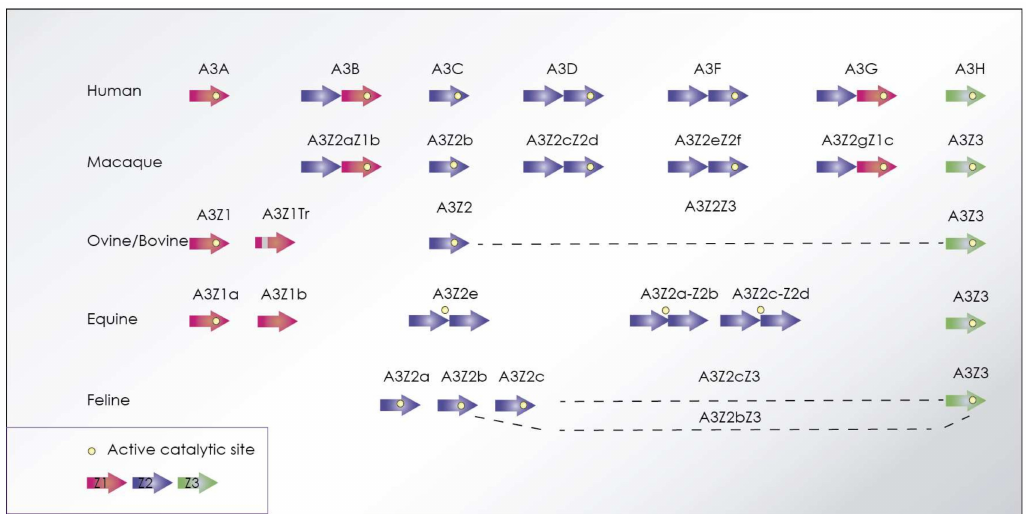
Figure 6. APOBEC3 proteins encoded by primates in comparison with ovine, bovine, equine, and felines highlighting Zn 2+ domains and deaminase catalytic site. Ovine, bovine, and feline encode alternative splicing derived proteins (highlighted with a discontinuous line) and a truncated isoform in the case of small